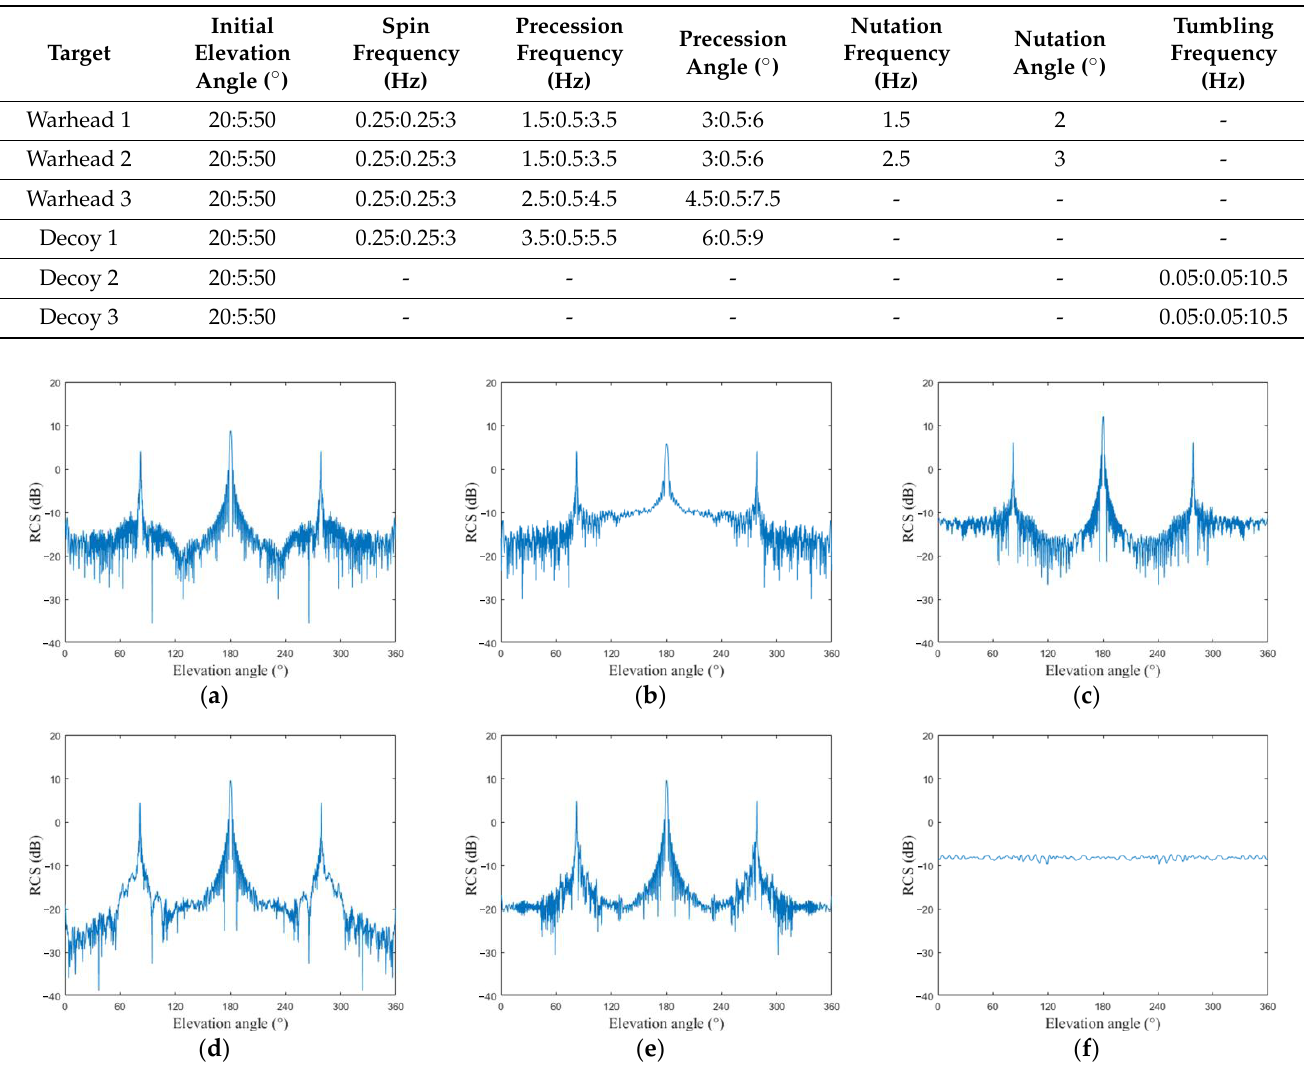
Figure 4. Variation of the static RCS (dB) of six targets with the elevation angle. ( a ) Warhead 1; ( b ) warhead 2; ( c ) warhead 3; ( d ) decoy 1; ( e ) decoy 2; ( f ) decoy 3.